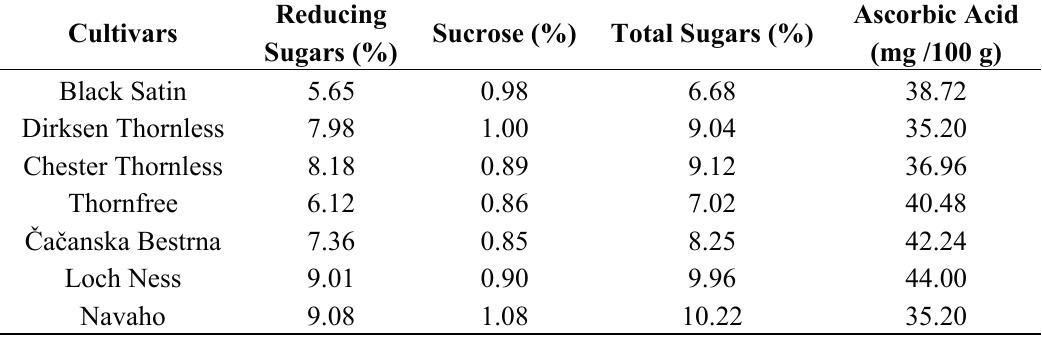
Table 6. Sugar and ascorbic acid contents (FW) in blackberry cultivars grown in Serbia [30].